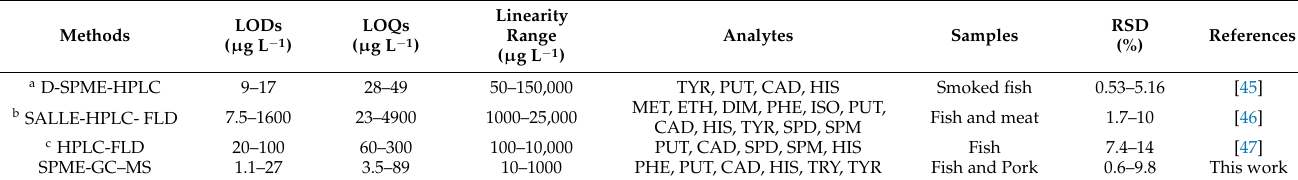
Table 2. Comparison of reported methods and the method developed in this